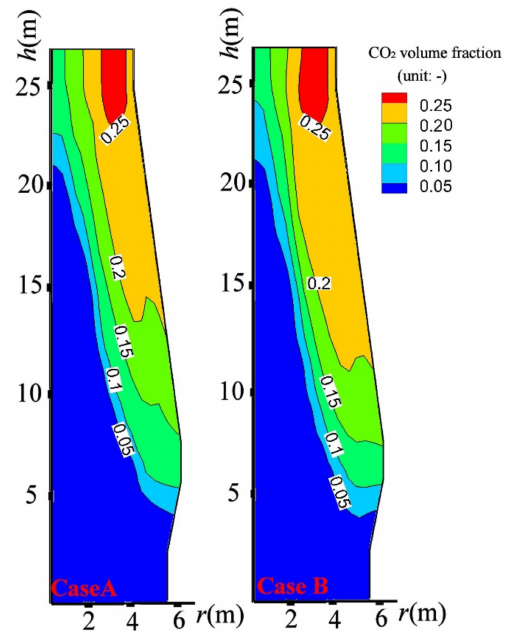
Figure 10. Profiles of CO 2 volume fraction in cases A and B.